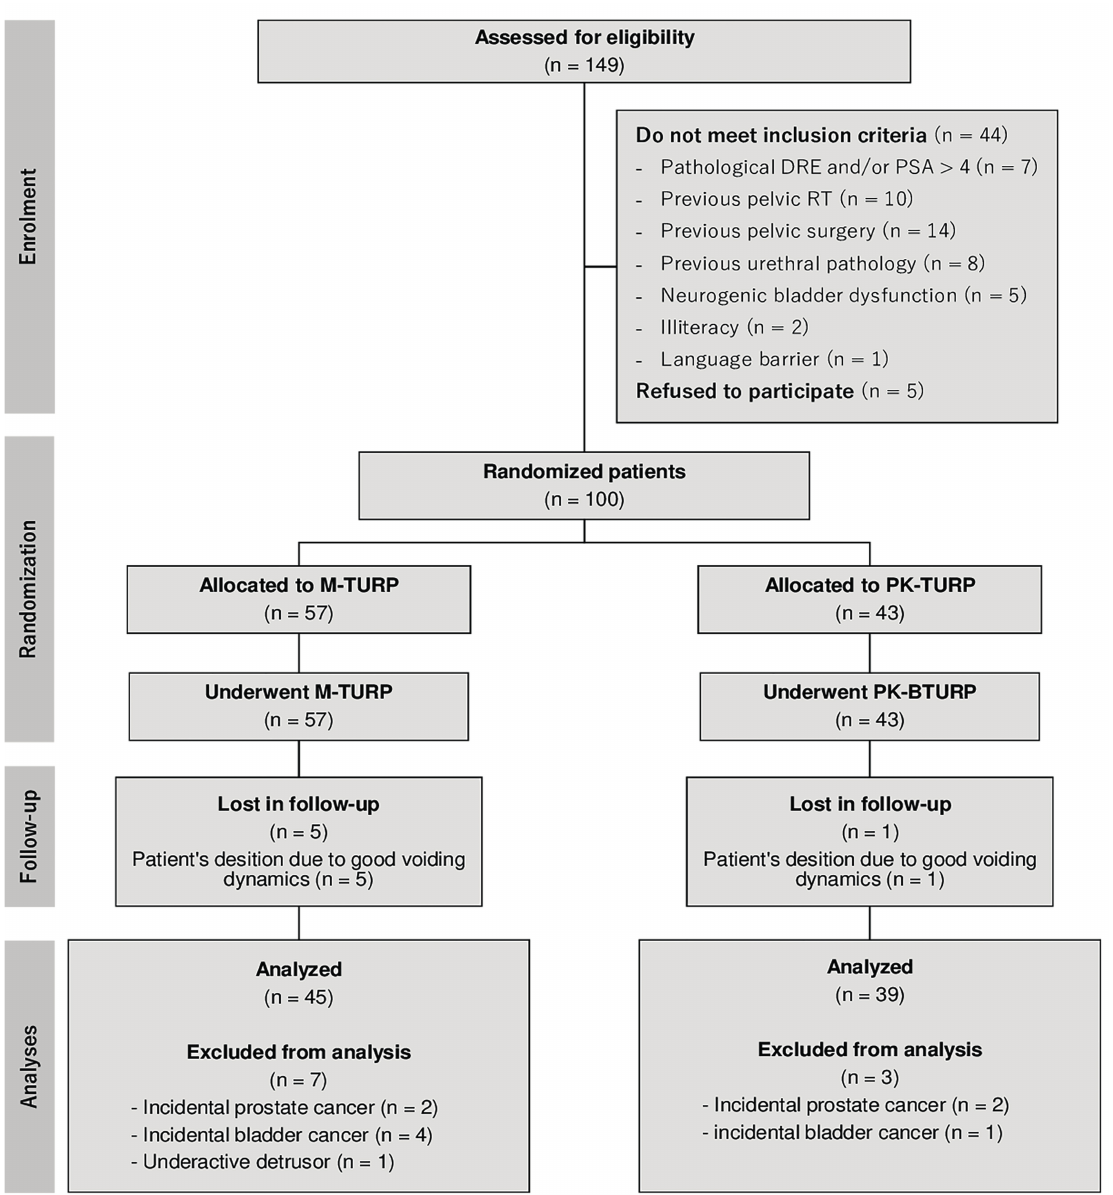
Figure 1 - CONSORT diagram including randomization, treatment, and follow-up of